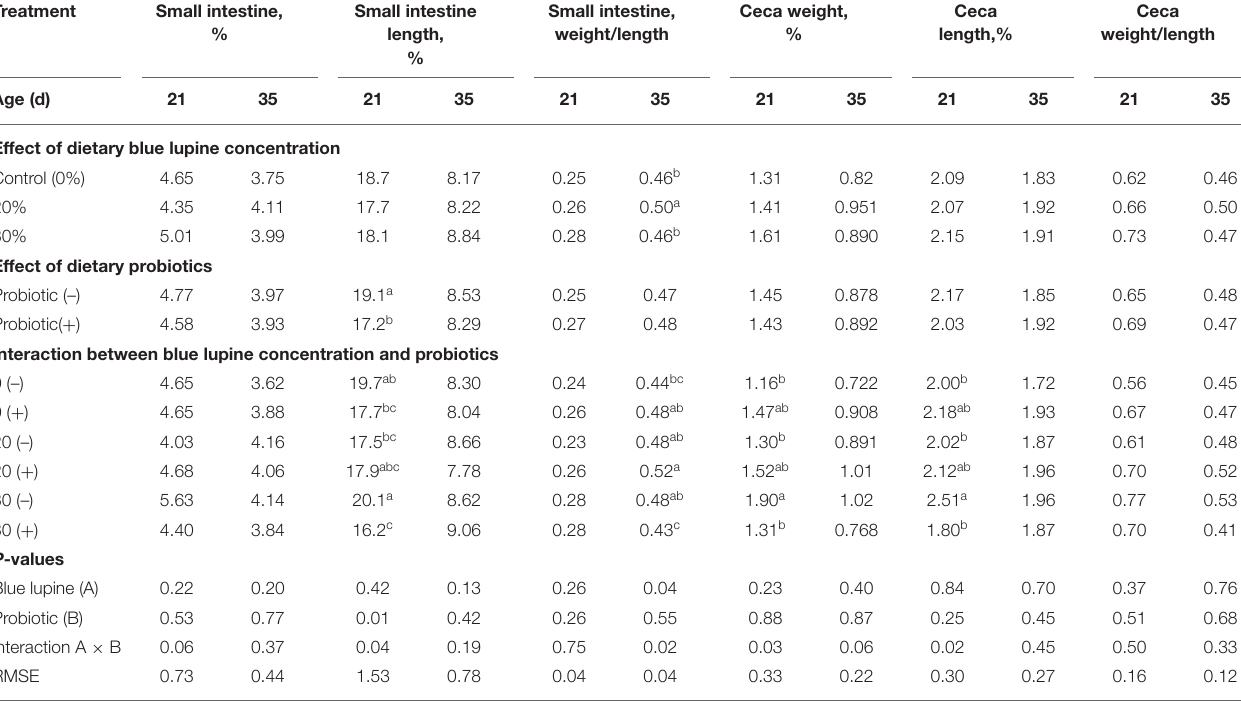
TABLE 10 | Effect of blue lupine and probiotics on small intestine parts of broiler chickens at 21 and 35 d of age. Treatment Small intestine, Small intestine Small intestine, % length,